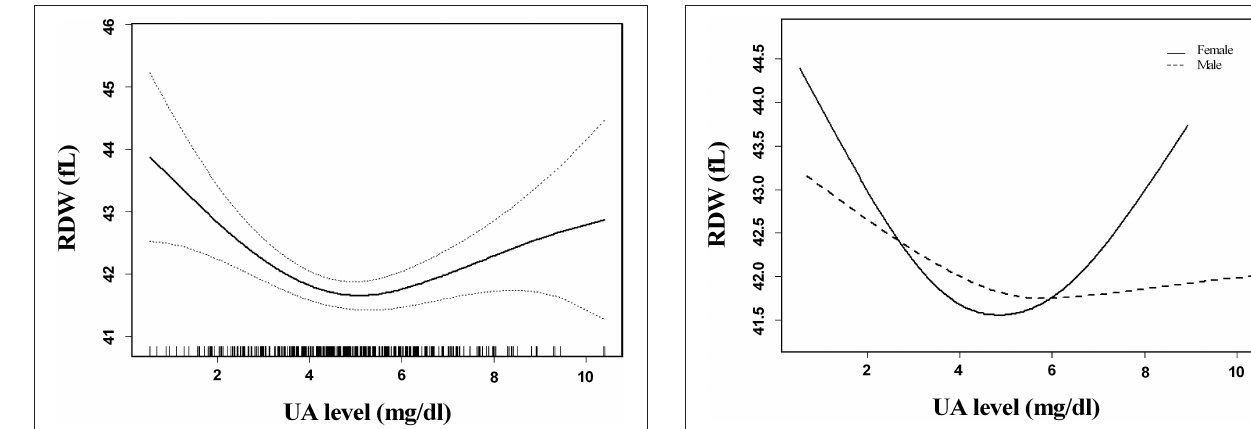
FIGURE 2 | Association between serum uric acid (SUA) levels and red blood cell distribution width (RDW) in all patients. The association between SUA levels and RDW followed a U-shaped relationship in all patients before adjusting for potential confounders ( p < 0.001). Solid lines represent the fitting curve, and dotted lines represent the corresponding 95% CI.